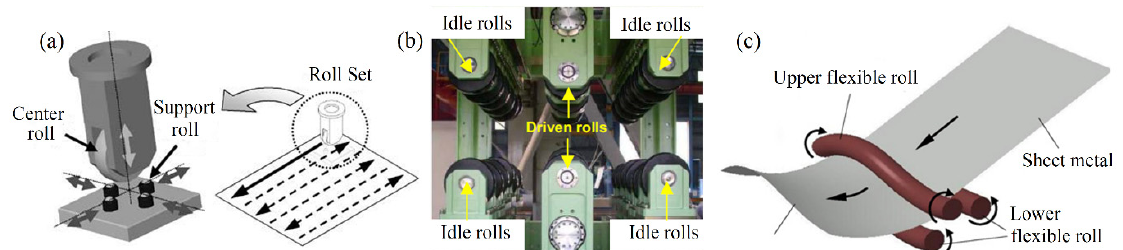
Figure 1. Schematic diagram of continuous forming technology of 3D surfaces: ( a ) FIRF process. With permission from Reference [6], copyright (2003) Elsevier; ( b ) LARS process. With permission from Reference [8], copyright (2010) Elsevier; ( c ) CFF process. With permission from Reference [11], copyright (2012) Elsevier.